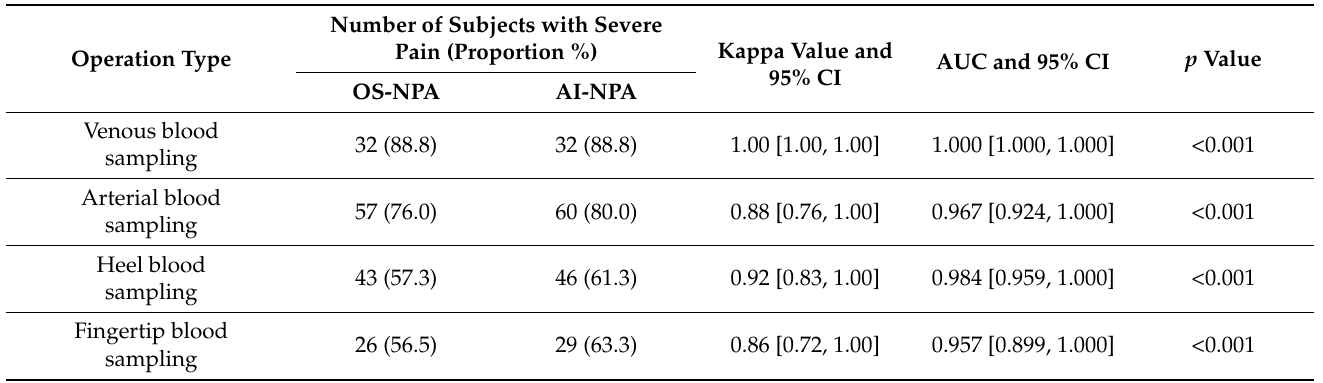
Table 4. Consistency analysis of AI-NPA and OS-NPA of severe